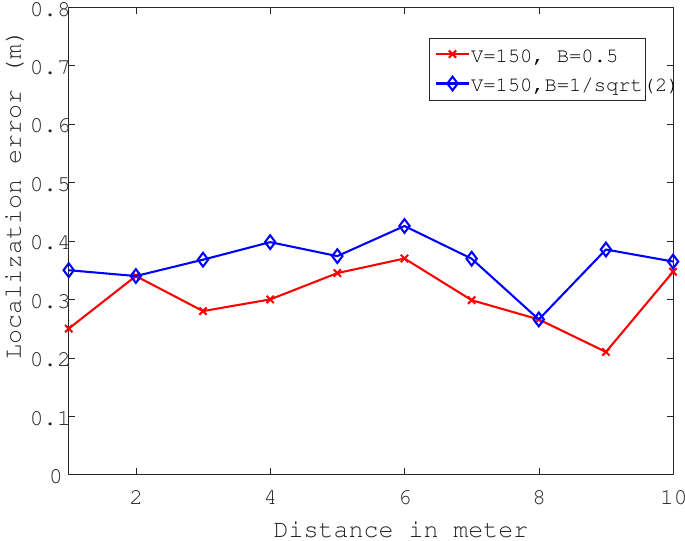
Figure 10. Effect of Multipath Fading on Localization